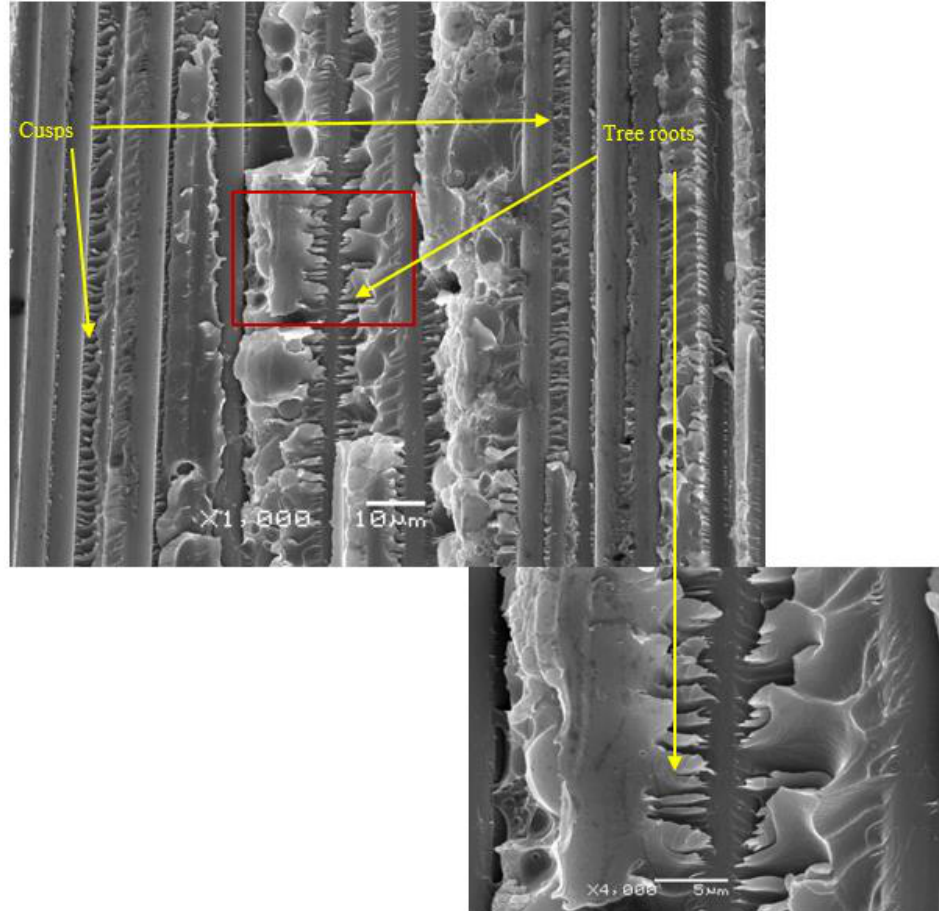
Figure 10. SEM micrographs of a fatigue specimen (counterspecimen in Figure 9) tested with the MMB device showing the presence of cusps and tree roots.